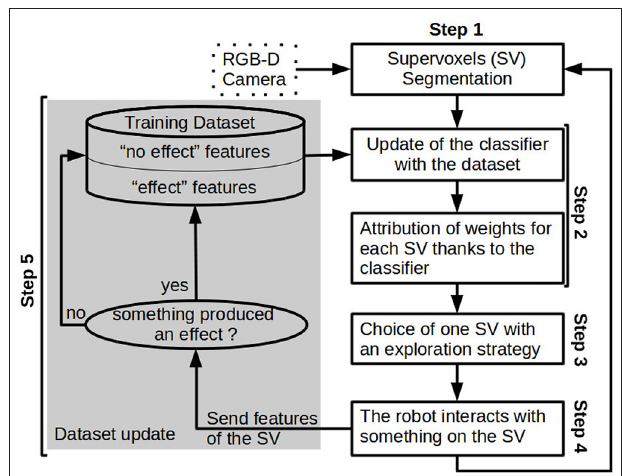
FIGURE 2 | Overview of the workflow followed during an exploration to build a relevance map.